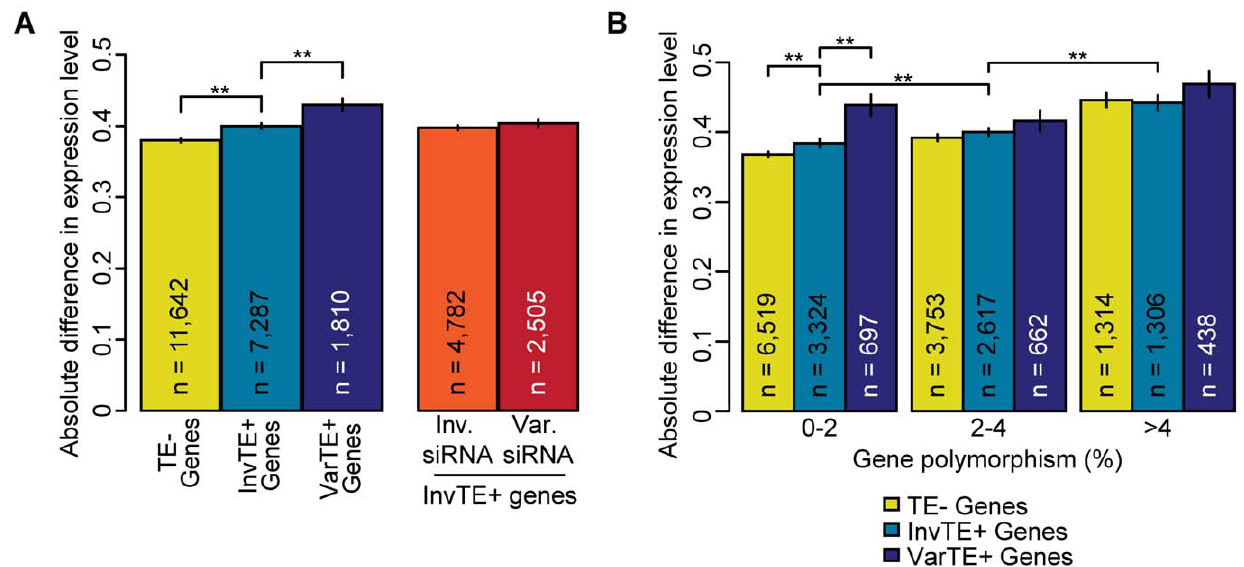
Figure 5. TE variation, siRNA–targeting, and differences in proximal gene expression. (a) Average absolute difference in gene expression for TE 2 genes (yellow), InvTE + genes (cyan) and VarTE + (navy) genes. MWU p[TE 2 /TE + ] , 2 6 10 2 16 , p[InvTE + /VarTE + ]=2 6 10 2 5 . Expression divergence is also shown for InvTE + genes divided by whether the proximal TEs are invariably (orange) or variably (red) targeted by siRNA. (b) TE 2 genes (yellow), InvTE + (cyan) genes and VarTE + (navy) genes were divided into subgroups depending on their polymorphism levels. Genes were binned by polymorphism levels into 0–2%, 2–4% and . 4% groups. The average absolute change in expression level for each subgroup of genes is shown. **=p , 0.01. Standard errors are shown.